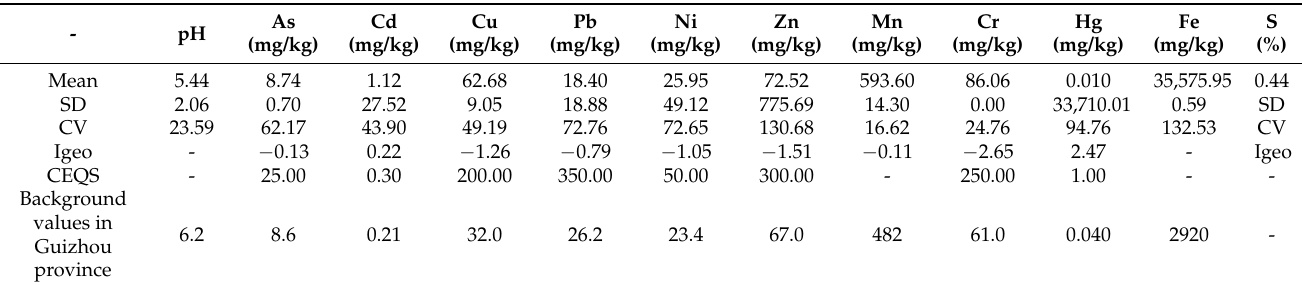
Table 1. The concentrations, coefficient of variation, and geoaccumulation index (Igeo) values of potentially toxic elements in soils of Youyu Catchment.